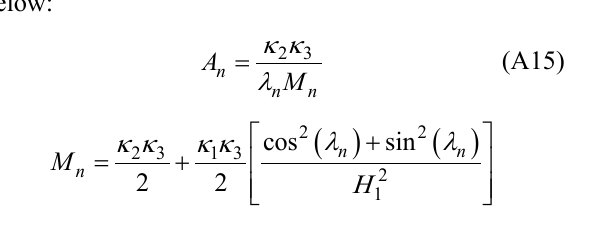
Table A3 Calculation parameters for